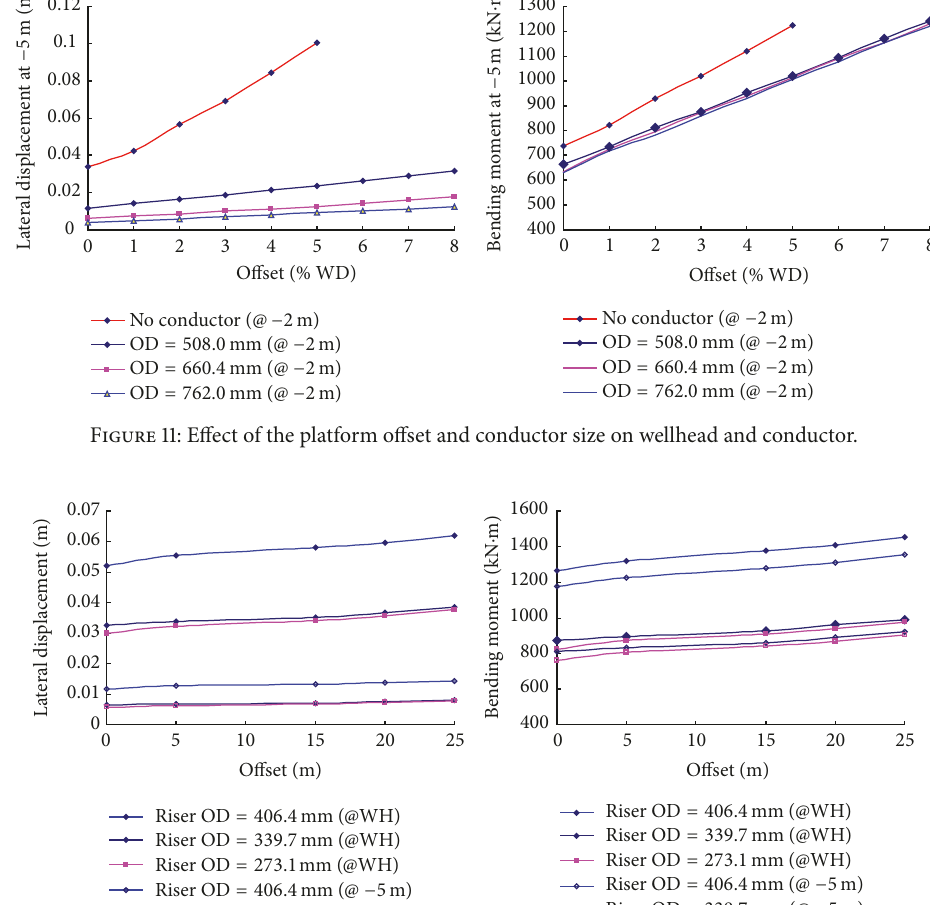
(2) Platform Surge Amplitude and Riser Size. Figure 12 displays the sensitivity of the lateral displacement and the bending moment to the variable surge amplitudes of platform and the